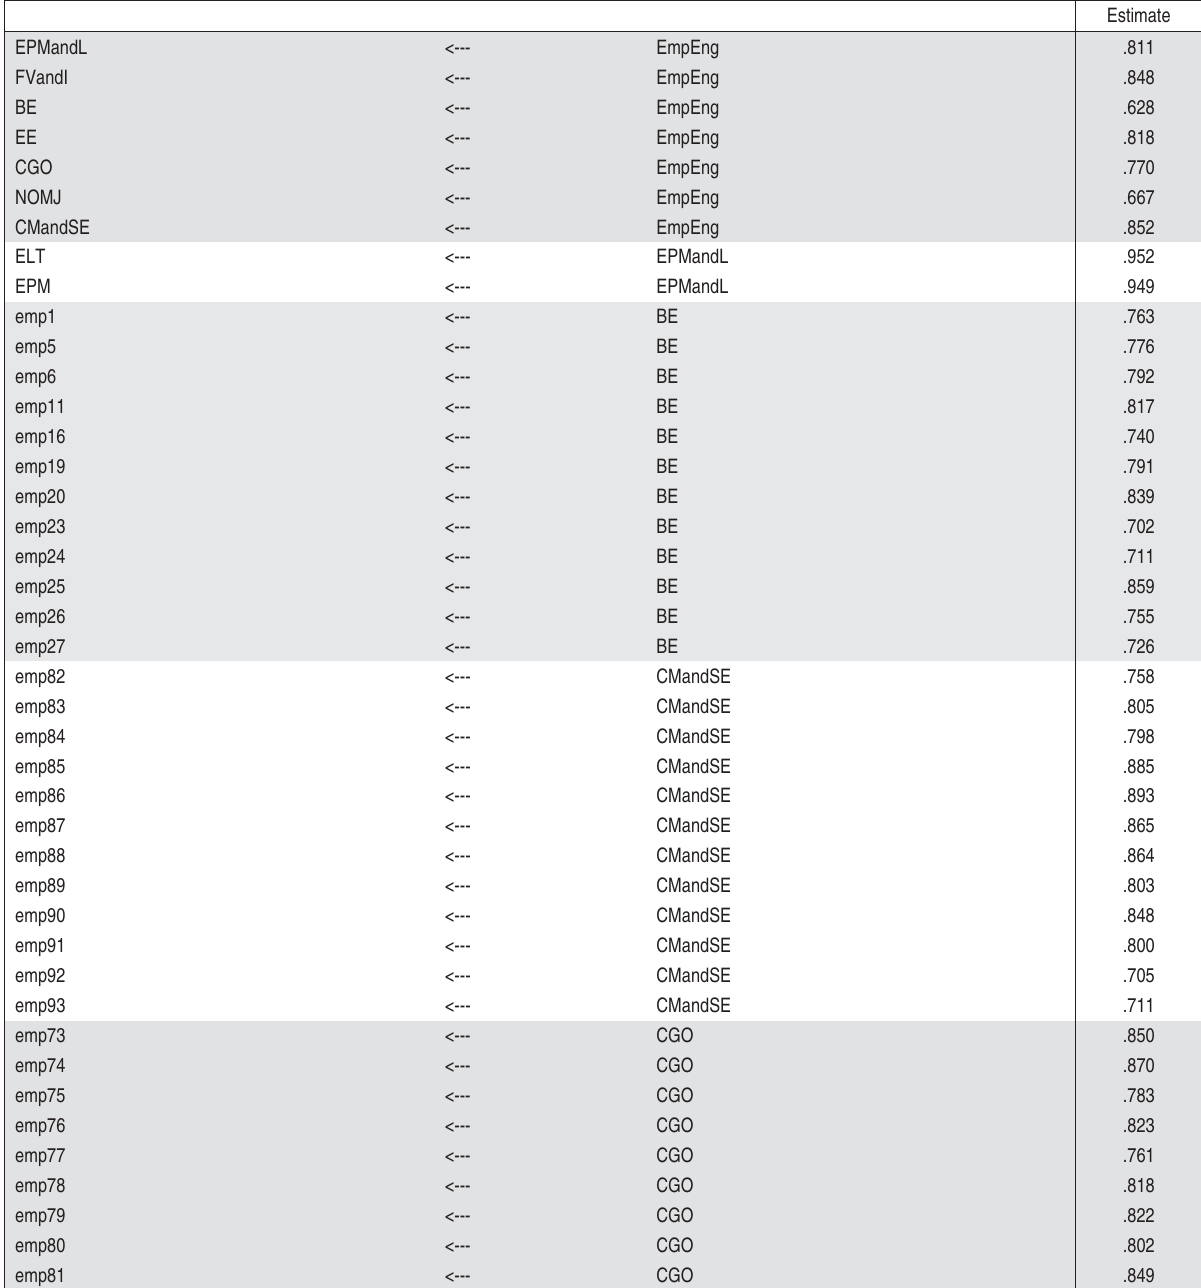
Table 5. Standardized regression